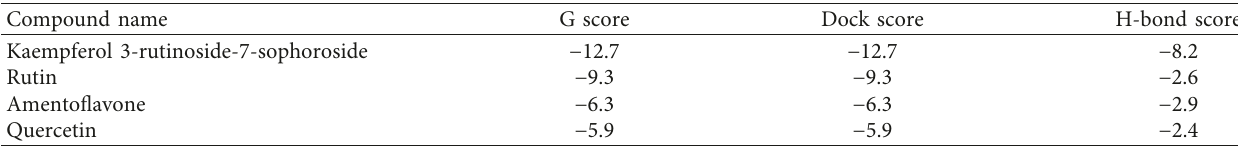
Figure 5: (a) A unique network demonstrating possible interactions between top-ranked flavonoids and the residues within the SauPBP2a active site. (b) Degree diagram. X -axis and Y -axis demonstrate the name of amino acid inside the SauPBP2a active site and its corresponding degree, respectively. SauPBP2a, Staphylococcus aureus penicillin-binding protein 2a. Table 3: Schr¨odinger Maestro docking score (kcal/mol) of top-ranked flavonoids based on the AutoDock tool, against SauPBP2a active site (PDB ID: 1MWT; chain B).